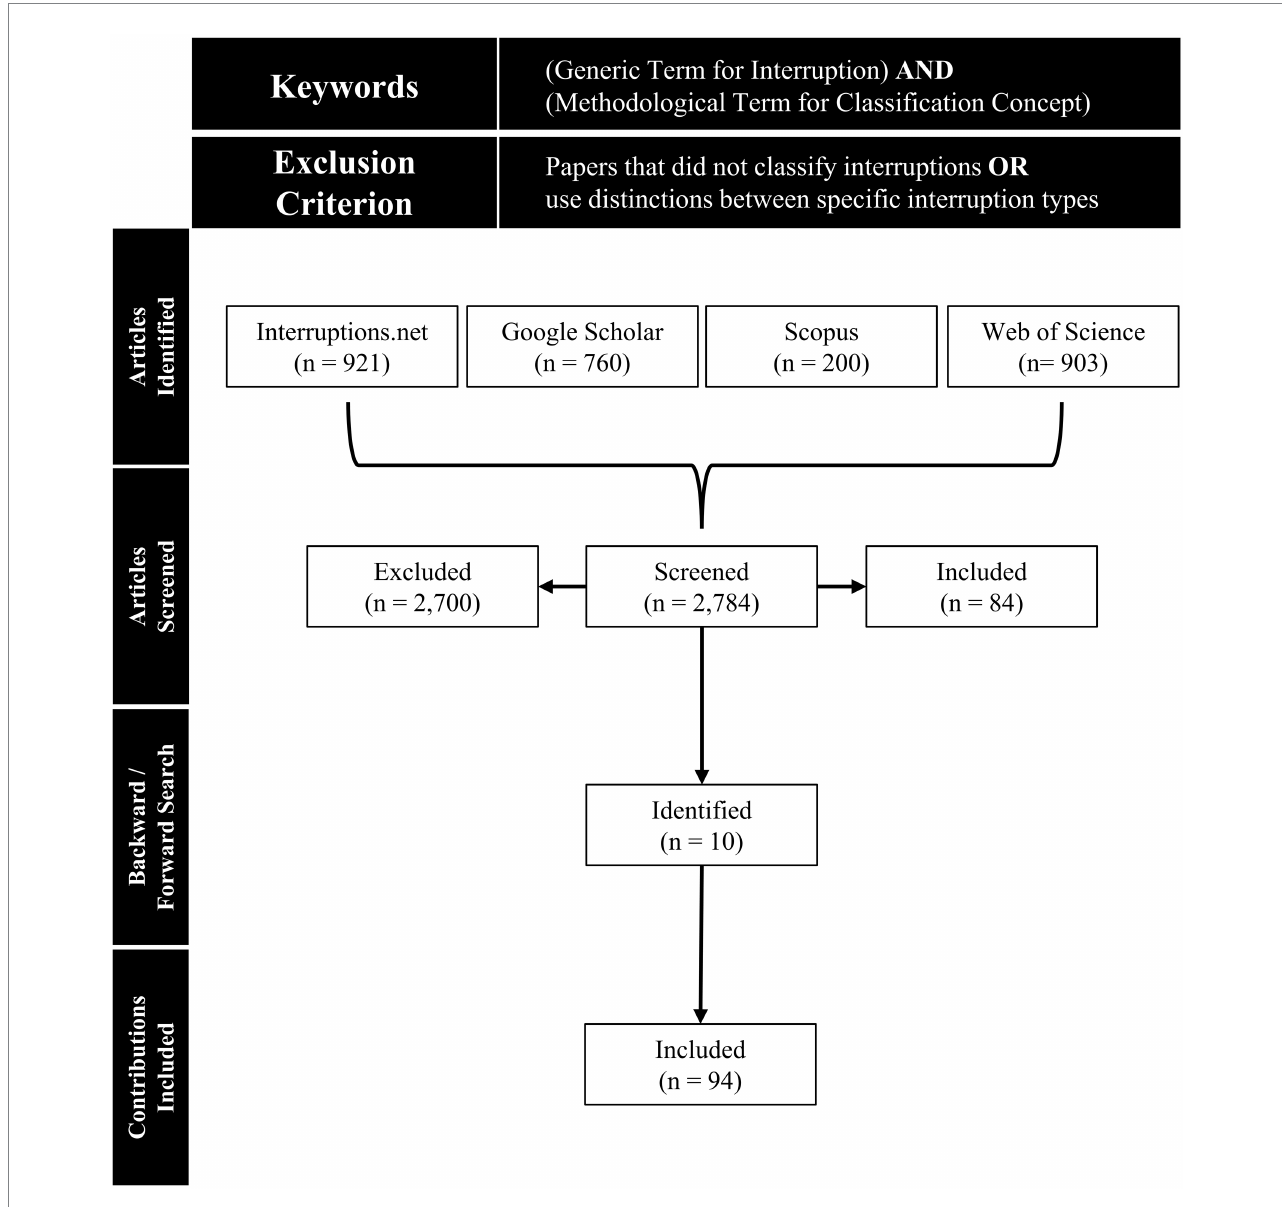
FIGURE 1 Flowchart of literature search